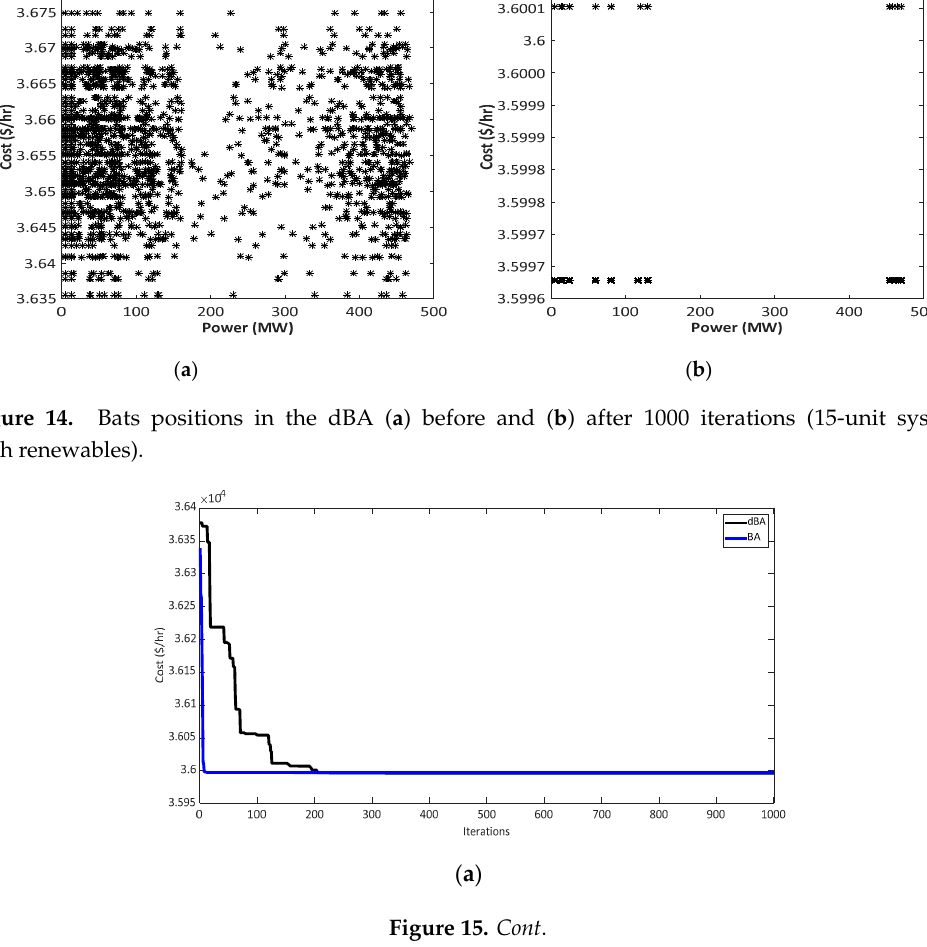
( b ) Figure 15. Convergence curve: ( a ) The cost convergence curve by the BA and dBA (15-unit system with renewables); ( b ) Magnified view. Figure 16. The pulse rate of the best bat of the BA and dBA.